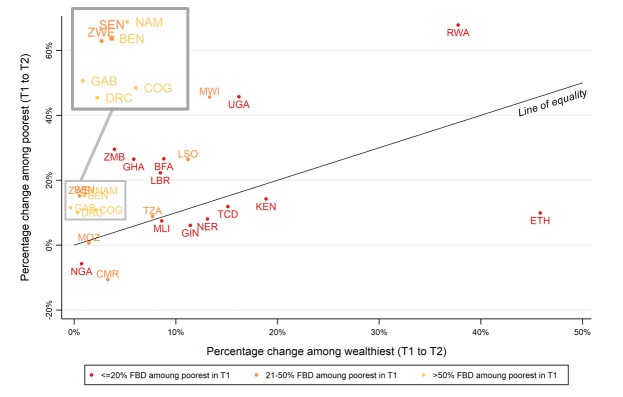
Percentage change in faculty-based deliveries (FBD) (T1 to T2) among wealthiest and poorest quintiles.